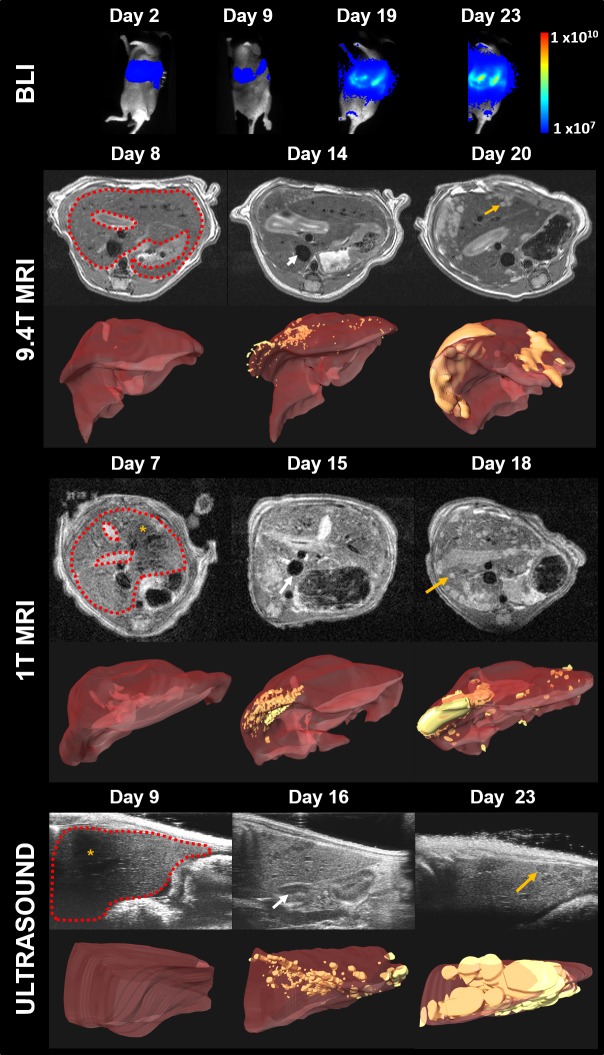
Representative images of the liver in a mouse model of colorectal metastasis, acquired over all time points, for all four modalities.Bioluminescence images (photon flux measured in p/s/cm2/str) have been scaled by the same logarithmic range across all time points. Bioluminescent signal can be seen at the location of the liver, which increases with the onset of the tumours. For US, high- and low-field MRI, typical slices are shown above corresponding three-dimensional visualisations of a manually segmented liver (red) and tumours (yellow). In the raw images, liver tissue has been delineated by a dashed red line, example tumours have been marked with orange arrows and example blood vessels are shown with a white arrow. Image artefacts have been demarcated with an orange star; signal loss occurs in MRI data due to cardiac motion, and ultrasound images suffer from transmission loss due to the ribs.